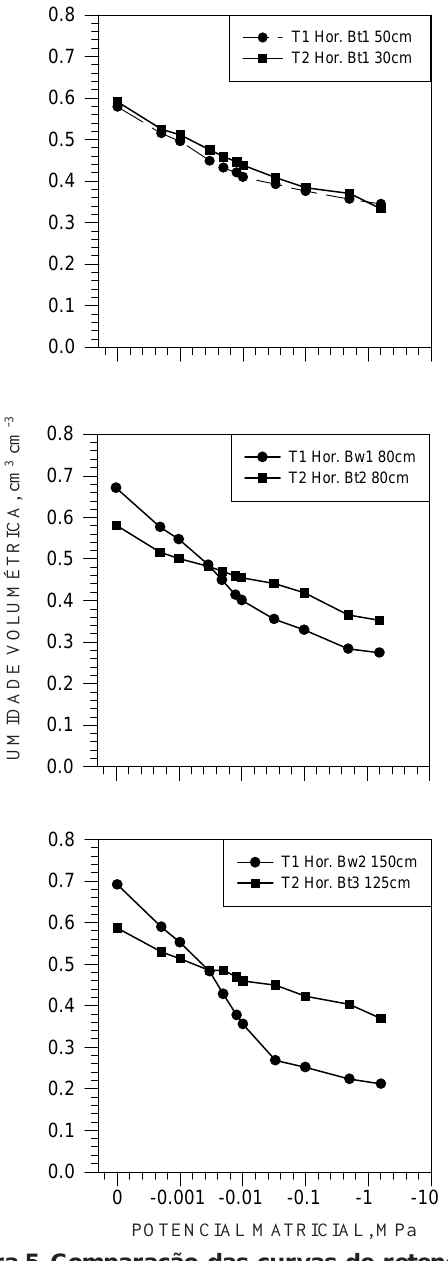
Figura 5. Comparação das curvas de retenção da água entre os horizontes dos dois perfis (T1 e T2) estudados. As curvas foram feitas utilizando o log do potencial matricial em